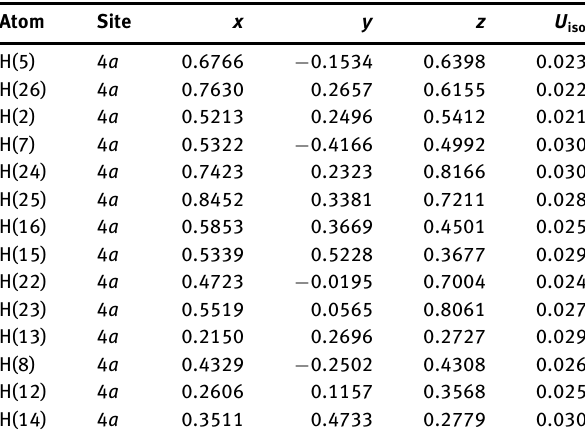
Table 2: Fractional atomic coordinates and isotropic or equivalent isotropic displacement parameters (Å 2